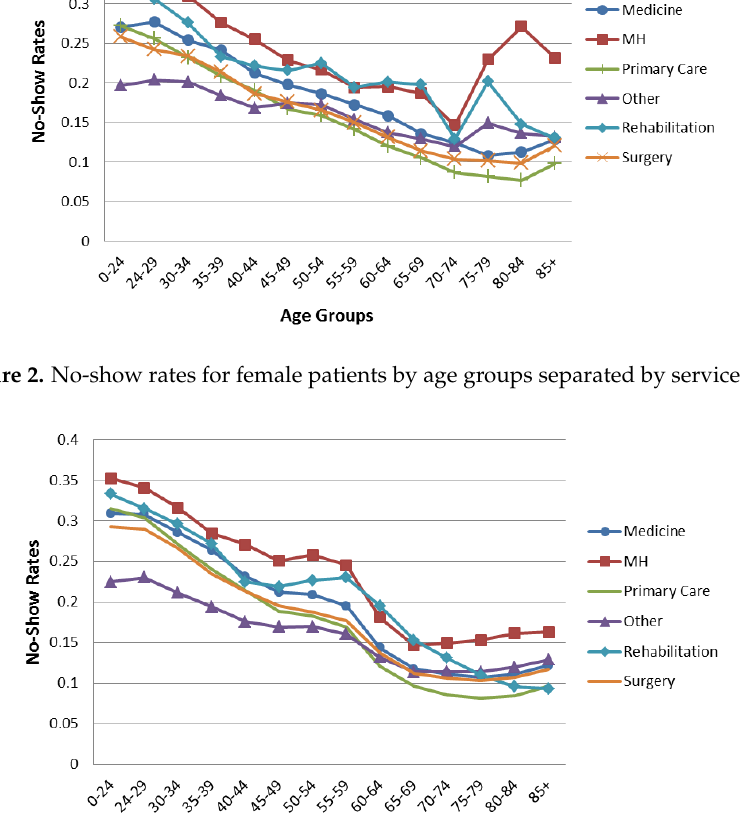
Figure 3. No-show rates for male patients by age groups separated by service line.